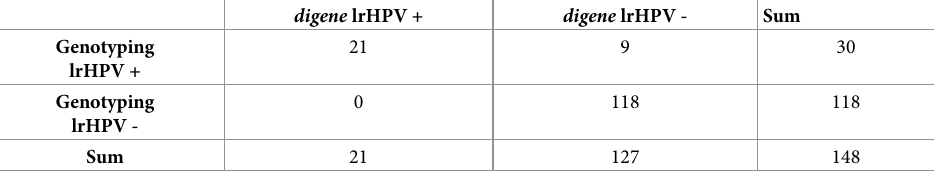
Table 3. Comparison of the vaginal health assay for the detection of lrHPV in DNA extracted from 148 vaginal samples by genotyping to that of the digene HC2 lrHPV assay. The genotyping assay was considered positive if the normalized number of reads assigned to any of the validated lrHPV types (6, 11, 42, 43, 44) divided by the number of reads assigned to a spike in control was greater than 0.1. The digene test was considered positive if the measured RLU was equal to or greater than the assay’s cutoff (RLU ratio of 1 or higher), as per the manufacturer’s